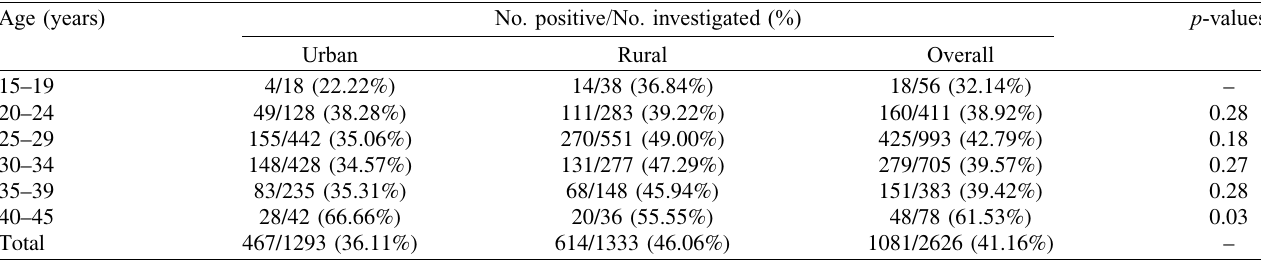
Table 1. Seroprevalence of Toxoplasma gondii infection in women of childbearing age according to age and area of residence. Age (years) No. positive/No. investigated